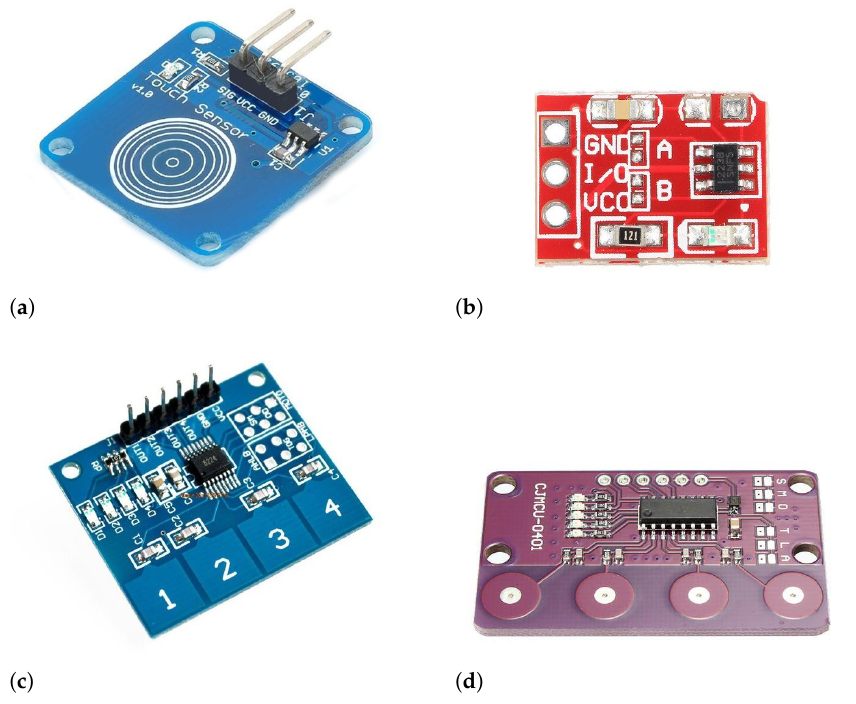
Figure 16. From ( a – d ), the figure depicts the four capacitive sensors tested. The individual electrical properties and datasheet for each sensor can be found in Table 7. Table 3. Effectiveness tests for sensor 1.